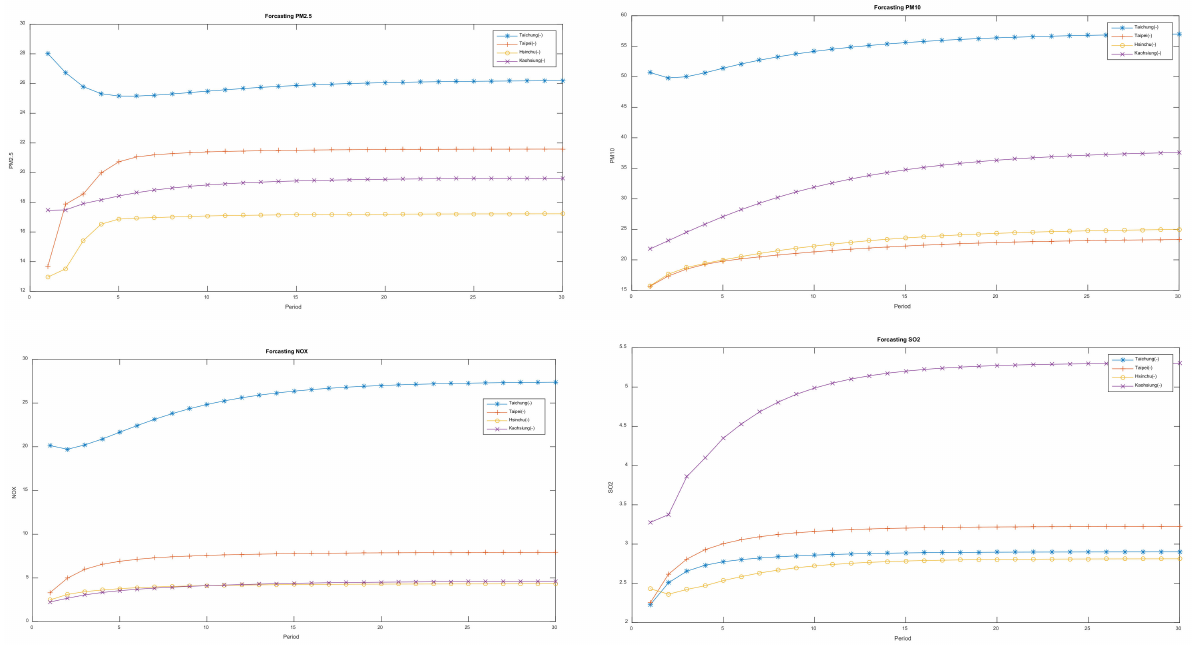
Figure 7. GSTAR(2) CFNN PSO